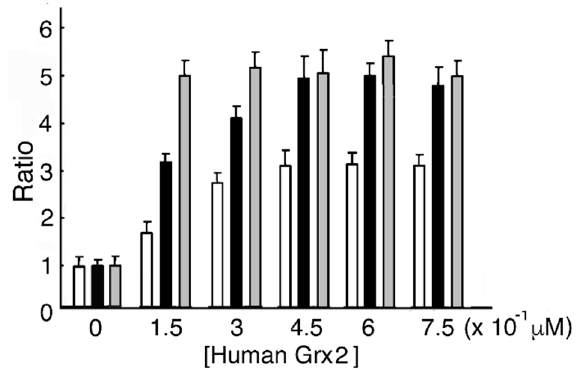
Figure 3. Human Grx2 and GSH dose-dependent MST activation. One MST reducing system contains various concentrations of human Grx2, human GRD, NADPH, and GSH, while the other reducing system contains human Grx2, human GRD, NADPH, and various concentrations of GSH. Each mixture was incubated at 20 °C for 10 min. The mixture is with ( ) or without ( ) GSH. ( ), Incubation with DTT-pretreated human Grx2.